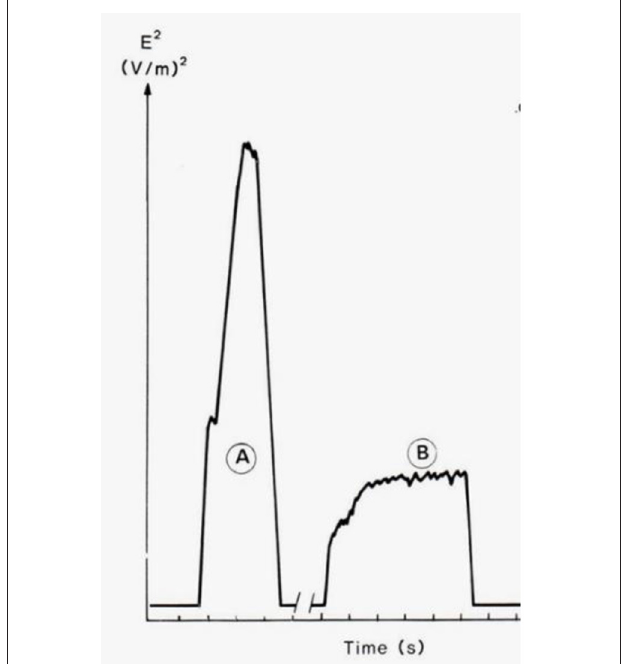
FIGURE 2 | The time dependence of the squared electric field strength (E 2 ) for two combinations of welding time and tuning, producing welding seams of the same quality ( 26). The area under the curves is approximately equal, which means that the same amount of energy is needed to produce the welding